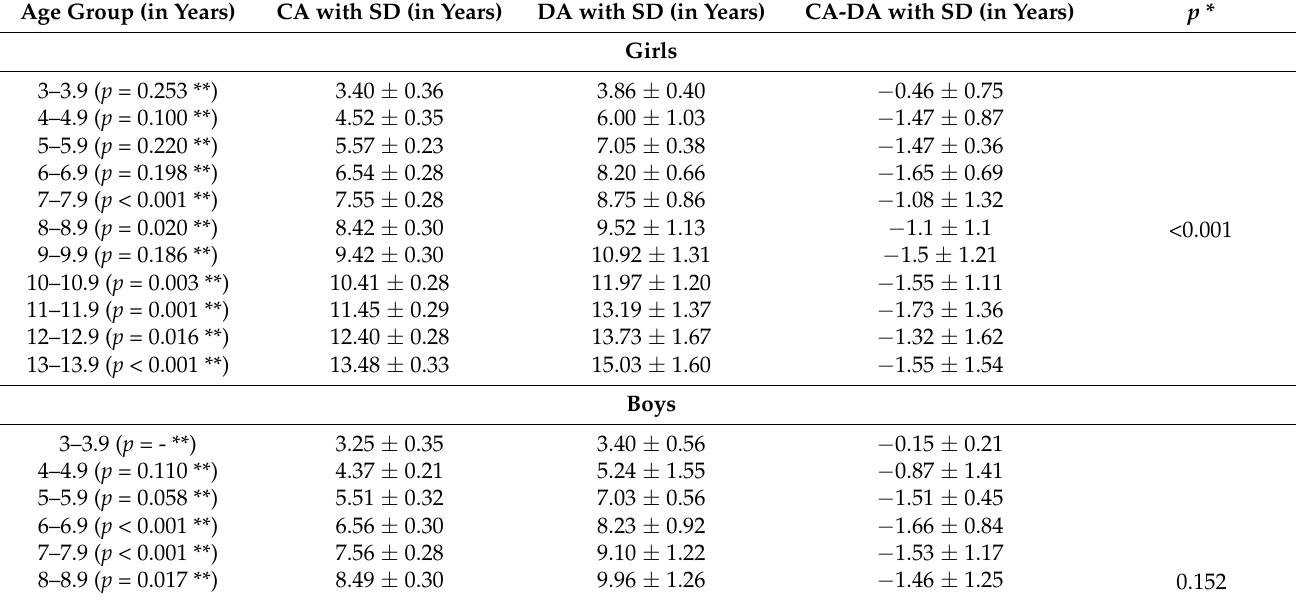
Table 4. Chronological age, dental age, and differences between the two for girls and boys.